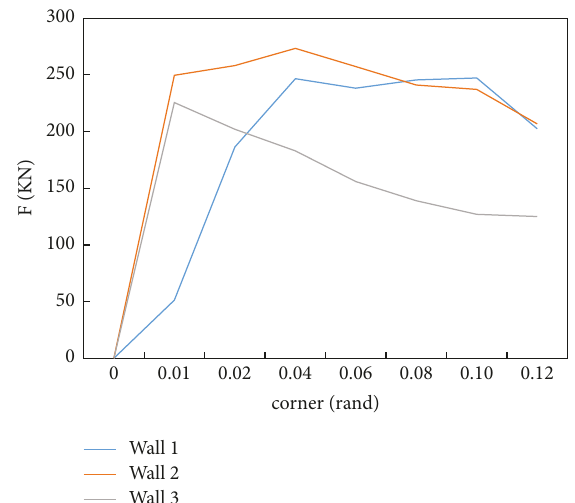
Figure 6: The relationship between load and plastic rotation angle.